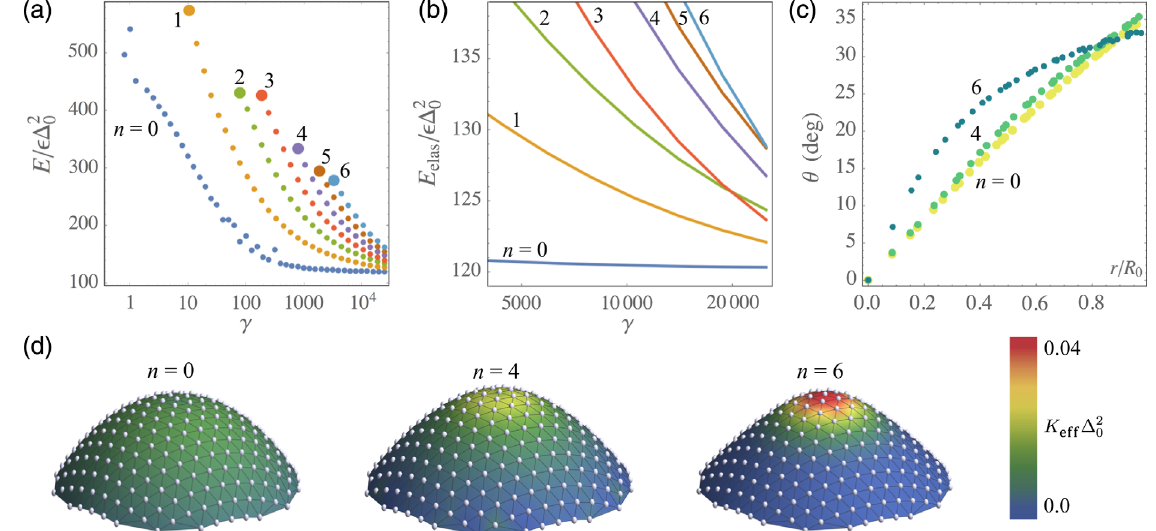
FIG. 5. (a) Total energy versus fil-vK number for various n . (b) Just the elastic contribution of the total energy, showing a trend for higher n modes overtaking lower ones. For γ ¼ 25 000 , (c) twist angles of filaments at a distance r from the bundle ’ s center. (d) Reconstructed surfaces (using the method detailed in Appendix C) for select values of n , showing how curvature becomes focused near the central defect for higher n .